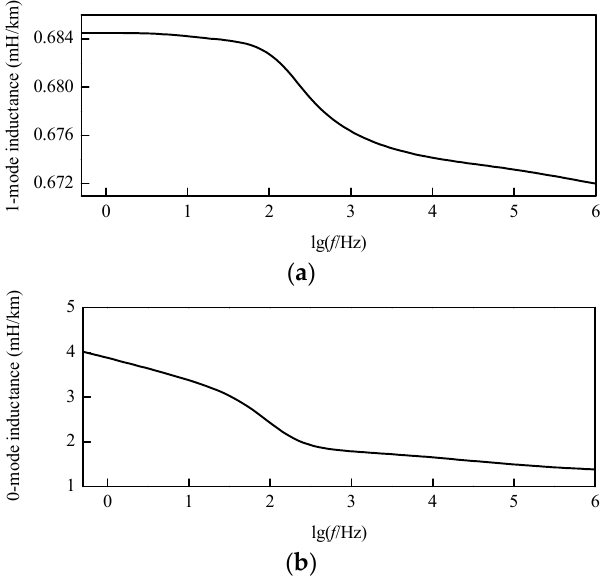
Figure 6. Modulus inductance characteristic curves: ( a ) 1-mode inductance; ( b ) 0-mode inductance.